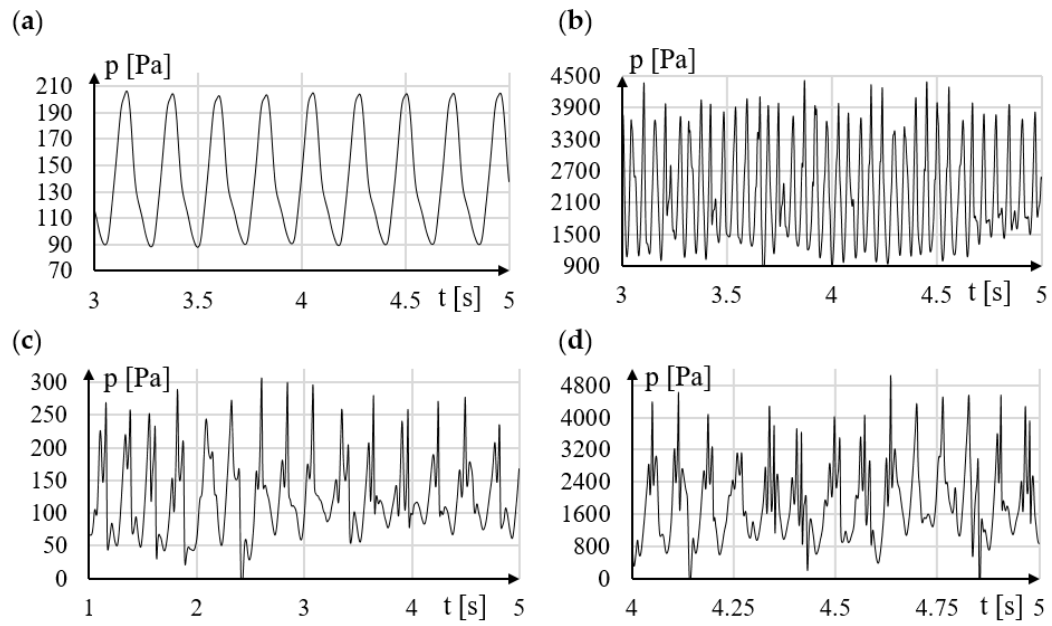
Figure 8. The influence of 1, 2, 3 and 4 surfaces modification on regularity of generated vortices for ( a ) P3 with v = 0.5 m/s, ( b ) P3 with v = 2 m/s, ( c ) P4 with v = 0.5 m/s, ( d ) P4 with v = 2 m/s.